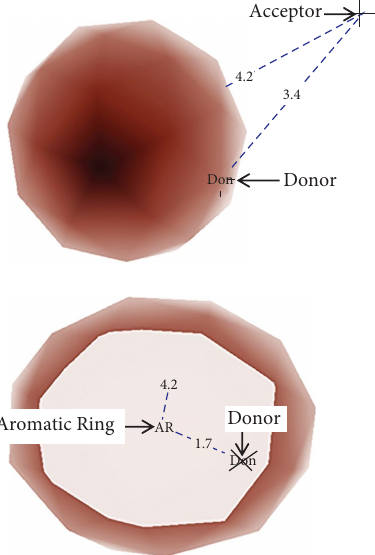
Figure 13: 2D projection of trajectory of four eigenvectors or PCs. *e PCs define the relative contribution of x, y, and z component of each c-alpha atom to the interrelated mode of motion conforming to that